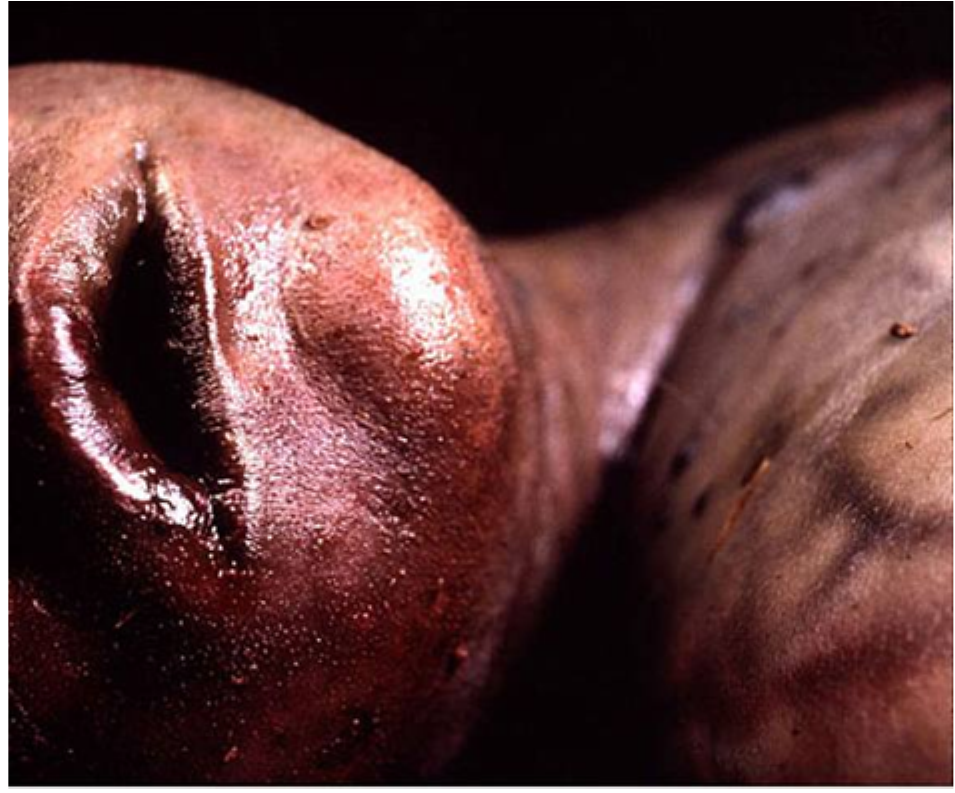
Andres Serrano, The Morgue (Death by Drowning II) , 1992. Cibachrome print. 49 x 59 ½ in. (124.4 x 151 cm.) Courtesy of Edward Tyler Nahem Fine Art, New York City. In Death by Drowning II , Serrano depicts the bloated and discolored upper body, zooming in on the mandorla-shaped mouth (Fig. 5). A human figure lying horizontally is sharply cropped above the upper lip leaving only the mouth, chin, and shoulders visible inside the pictorial frame. Light falls on the lips and chin, drawing attention to the wrinkly surface of the skin. The mouth becomes like a gaping wound in the face and this same shape is reminiscent of the side wound as depicted in an illuminated manuscript at the Bibliothèque nationale de France (Fig. 6). Divided into three registers, the Arma Christi shows the Crucifixion at the top, Christ’s side wound in the center, and the flagellation column at the bottom. In the center register the side wound is magnified, taking on its own physical bodily presence and transforming Christ’s full body, as seen on the Cross in the top register, into a giant wound. The faded appearance of the side wound in the manuscript is the result